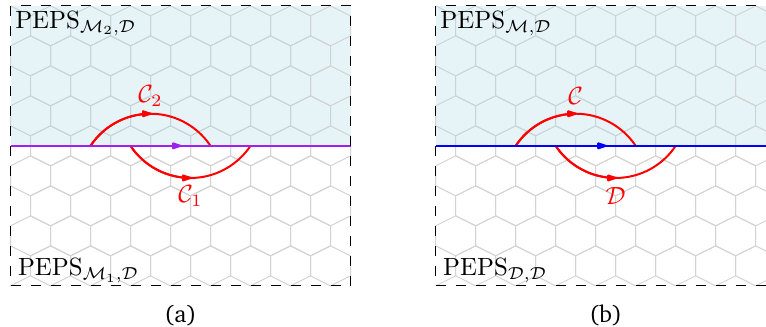
Figure 1: (a) Two PEPS representations for the ground state of the same string net model D , determined by module categories M and M . (b) For the particular 1 2 = D and M = M , explicit tensors can be constructed in terms of the case that M 1 2 F -symbols of M as a ( C , D ) -bimodule